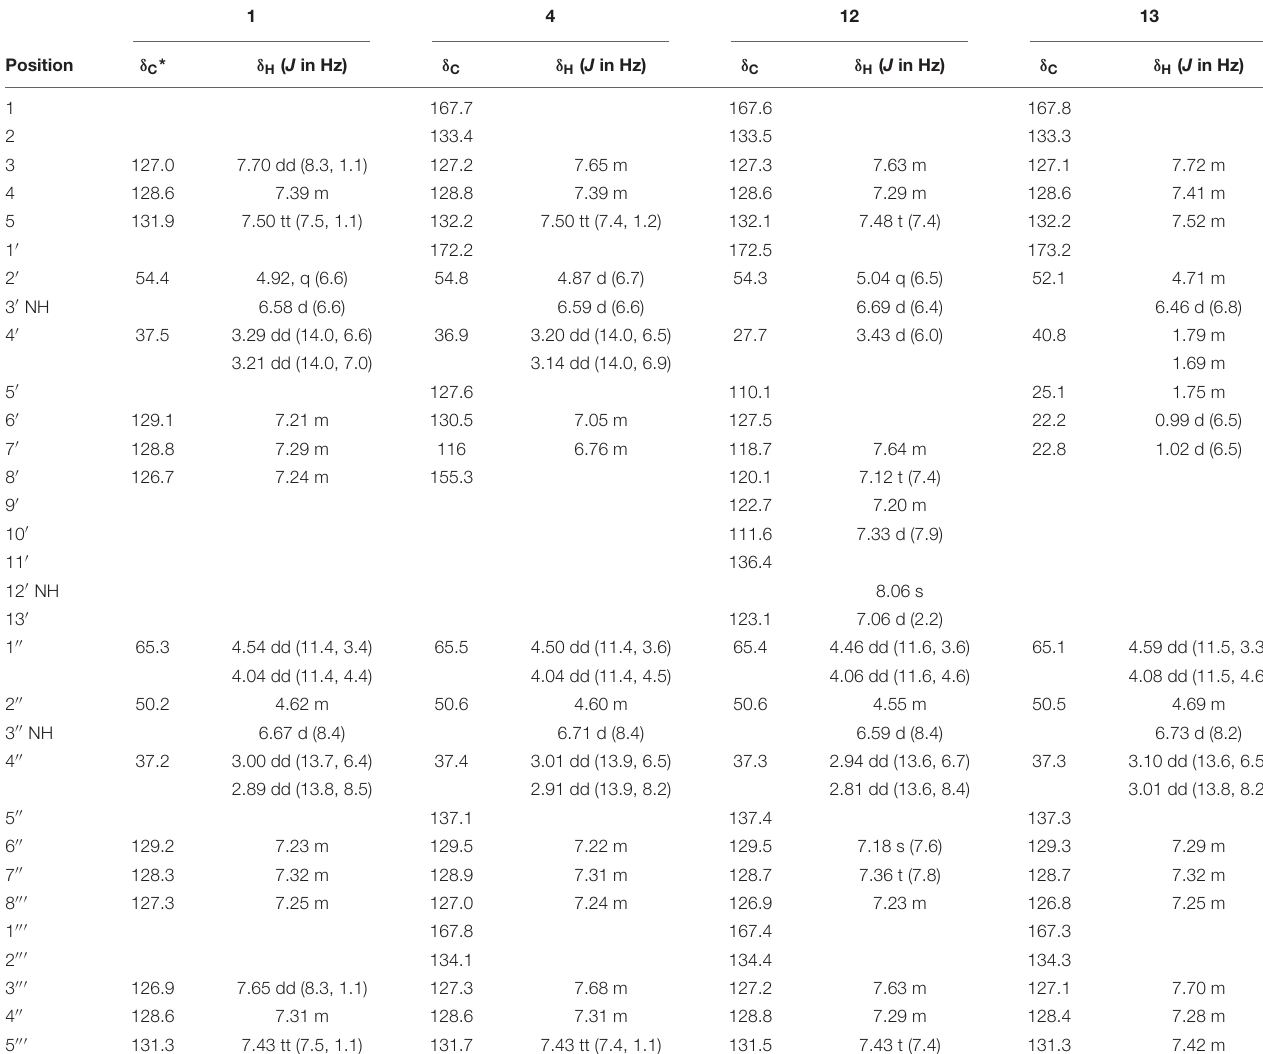
TABLE 1 | 1 H and 13 C NMR shifts for asperphenamates F (1), Y (4), and W (12) and L (13) in chloroform (CDCl 3